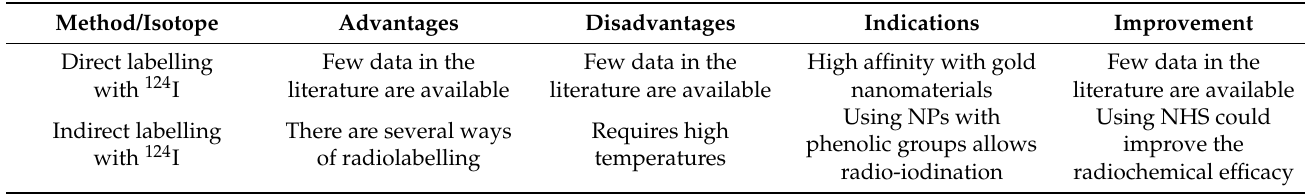
Table 4. Pros and cons of different methods for radiolabelling NPs with